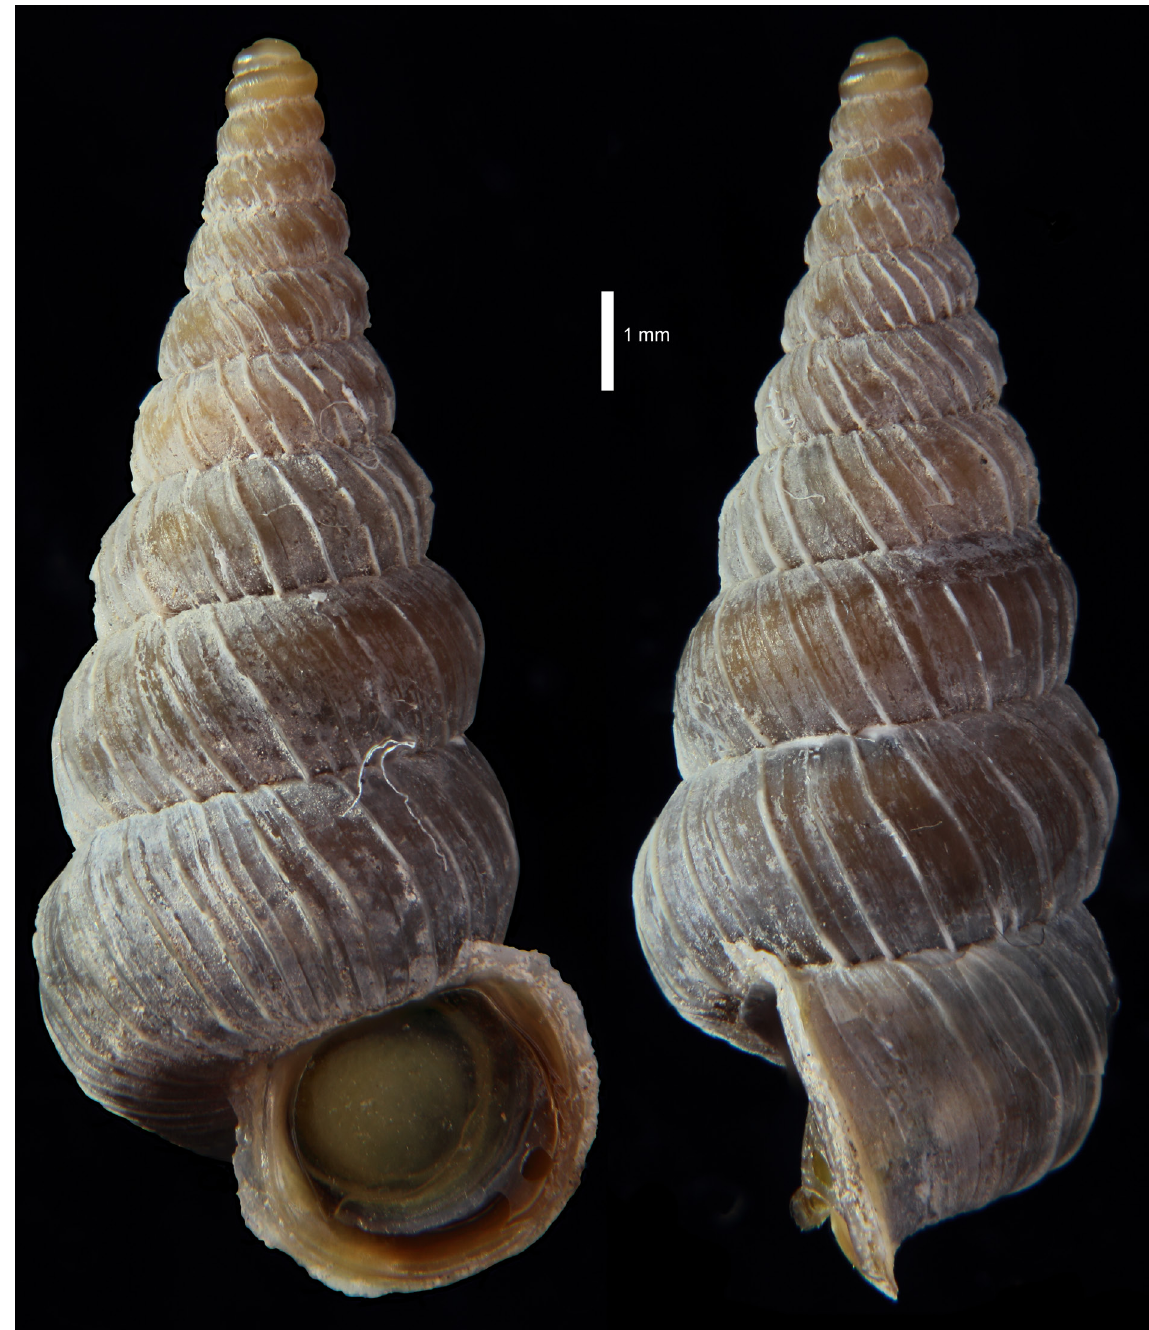
Fig. 9. Cochlostoma (Lovcenia) dalmatinum (L. Pfeiffer, 1863), Kameno, 6 km from Crkvice, Montenegro (NHMW